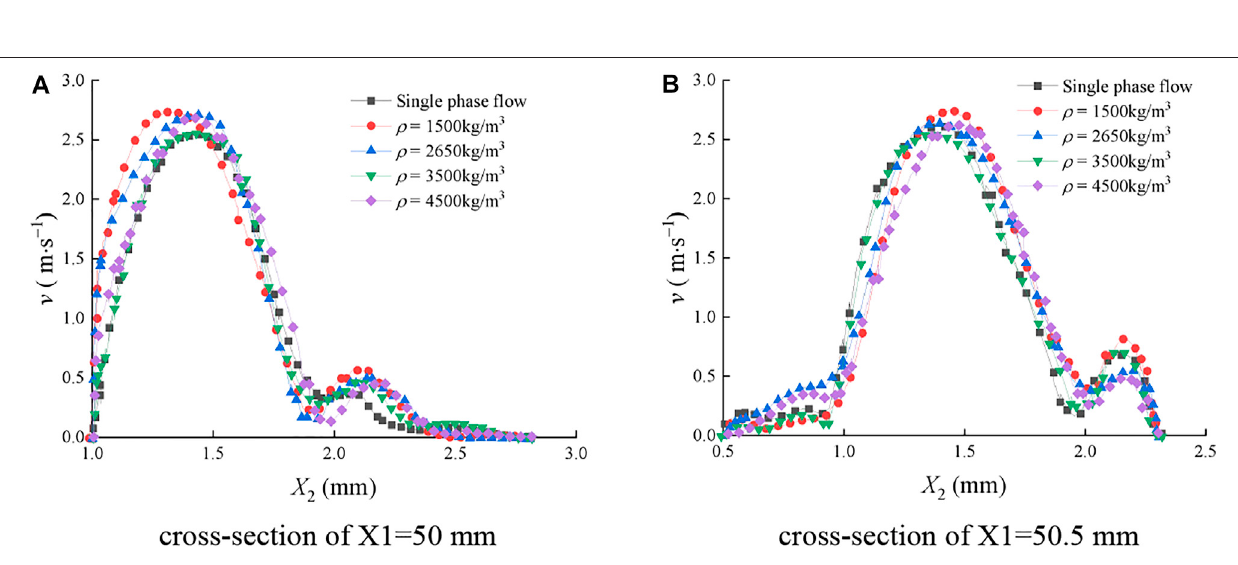
Frontiers in Physics |